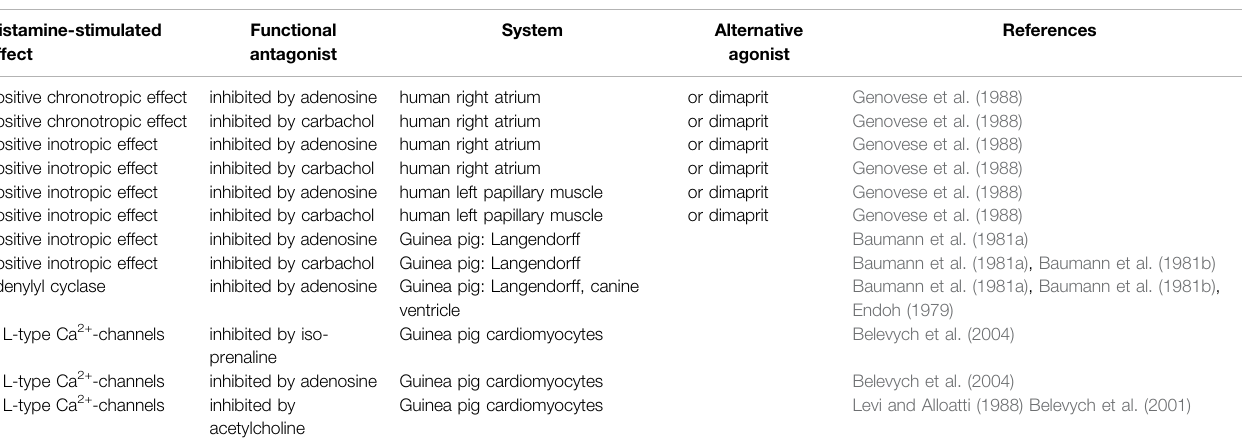
TABLE 3 | Alterations of histamine-induced effects in the